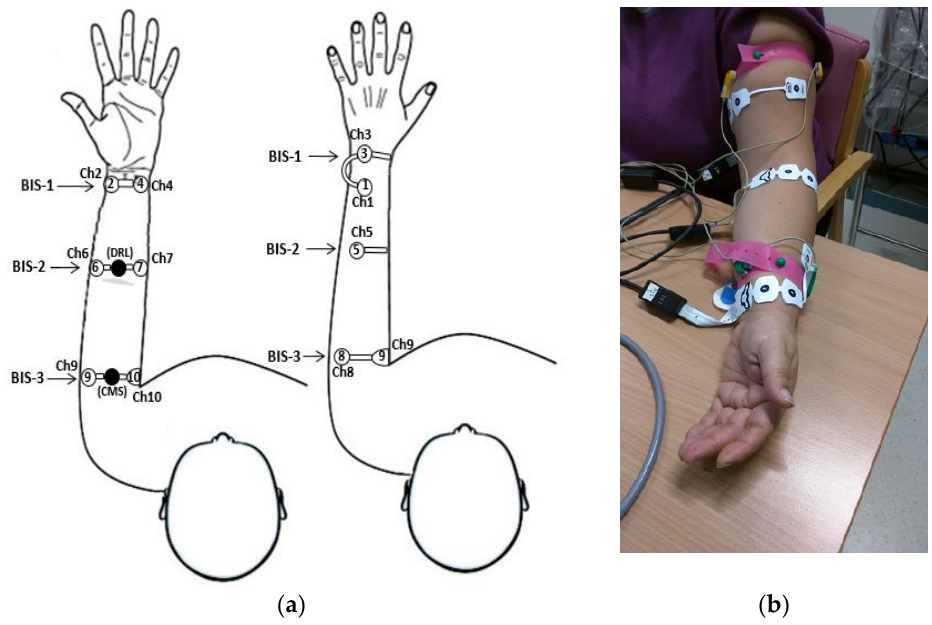
Figure 4. Anatomical position of the 10 unipolar left-arm potential mapping channels, using the three BIS-Quatro TM sensor strips ( a ), and wired up arm photo ( b ). BIS: BIS-Quatro TM sensor system; DRL: driven right leg; CMS: common signal reference electrode. Table 1. Definition and anatomical location of studied left-arm bipolar leads. BIS: BIS-Quatro TM sensors system.